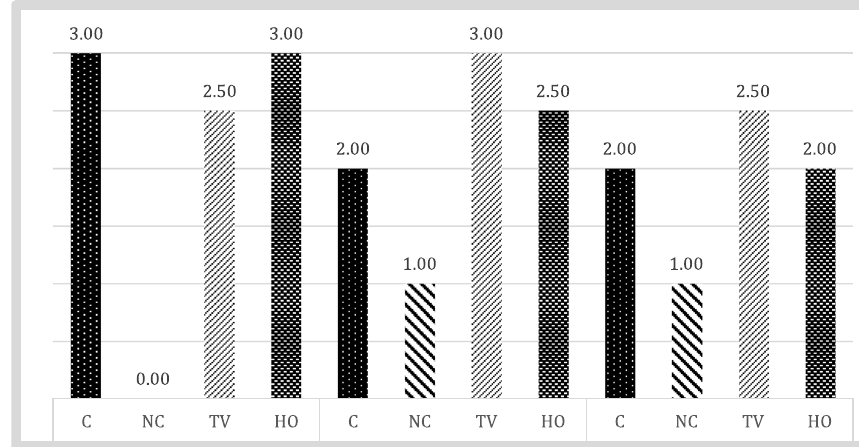
Fig. 1 Comparisons of histopathological findings of the groups